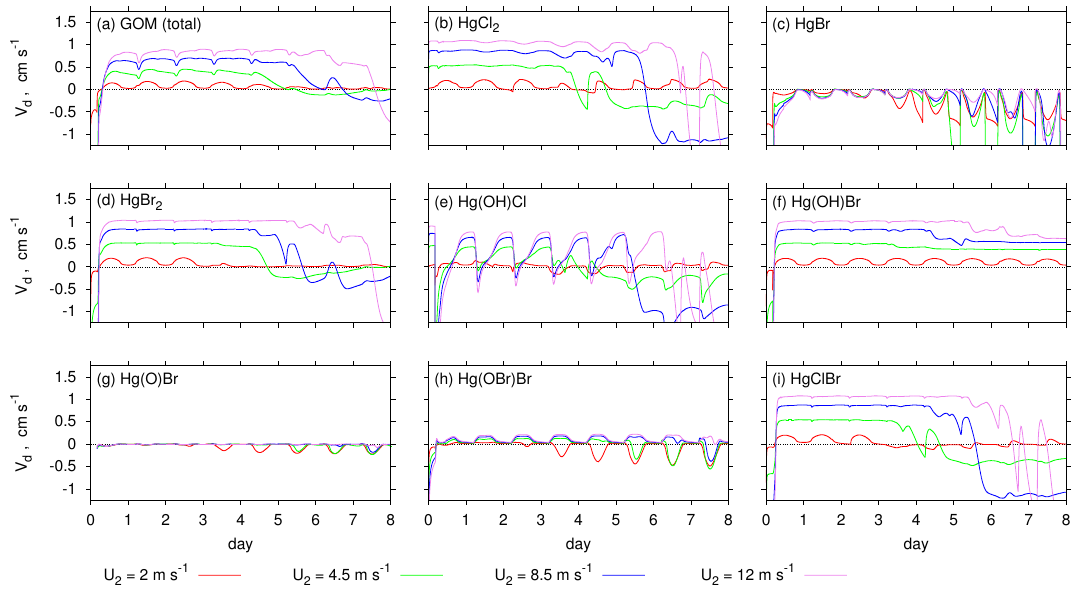
Fig. 5. Apparent dry deposition velocities of GOM and its each component species (except Hg(OH) 2 , which constitutes a minimal partitioning in GOM simulated here) at 1.5 m above the snow surface from model runs employing scenario 1A at U 2 = 2 . 0 m s − 1 (red lines), 4.5 m s − 1 (green lines), 8.5 m s − 1 (blue lines), and 12.0 m s − 1 (violet lines): (a) the sum of all GOM species, (b) HgCl 2 , (c) HgBr, (d) HgBr 2 , (e) Hg(OH)Cl, (f) Hg(OH)Br, (g) Hg(O)Br, (h) Hg(OBr)Br, and (i) HgClBr. T = 298 K assumed for K H (Hg II ) & K eq (Hg II ) only; otherwise T = 253 K